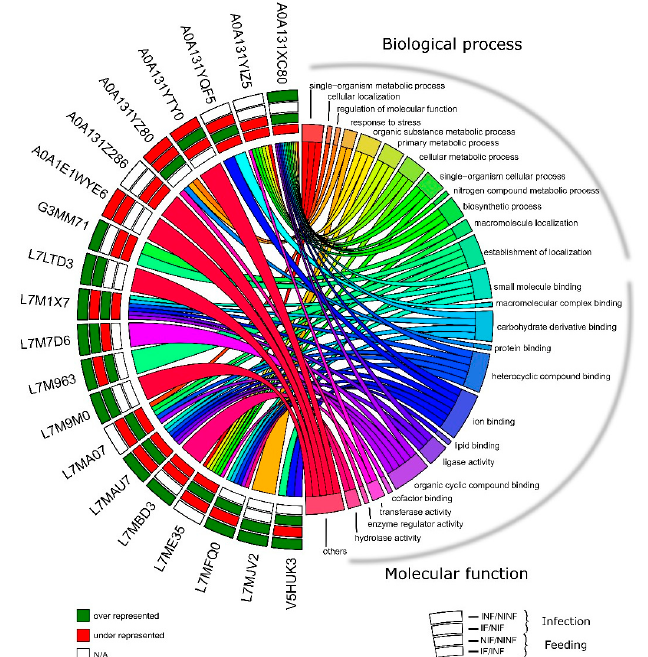
Figure 5. Chord diagram presenting gene ontology of the di ff erentially represented proteins in R. bursa sialoproteome in response to infection and / or feeding. Each protein found in each comparison is shown on the left alongside with UniProt ID, while the GO clusters are shown on the right. Outer annulus to inner annulus: infection in unfed ticks (INF / NINF), infection in fed ticks (IF / NIF), feeding in uninfected ticks (NIF / NINF), and feeding in infected ticks (IF / INF). Green square: over-represented, red square: under-represented and white square: not